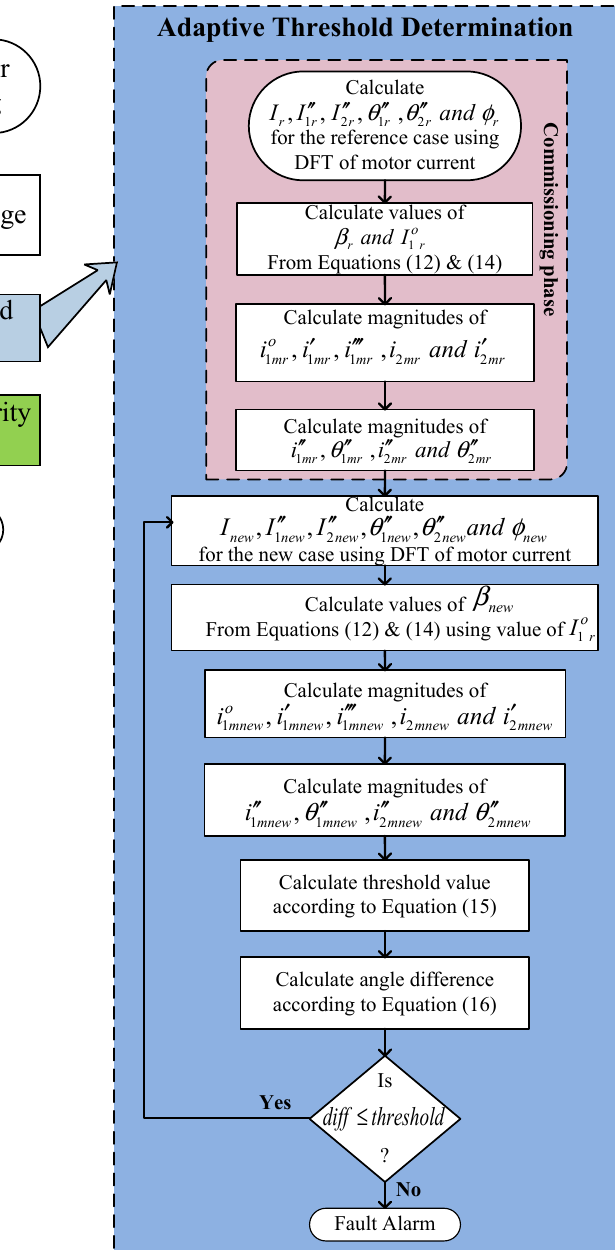
Figure 11. A flowchart summarizing the overall proposed scheme.